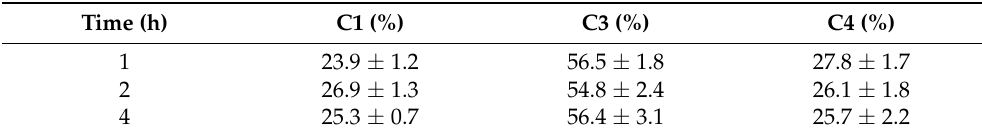
Table 5. Uptake values in LNCaP cells evaluated at different times. Values are expressed as means ± SD, n =